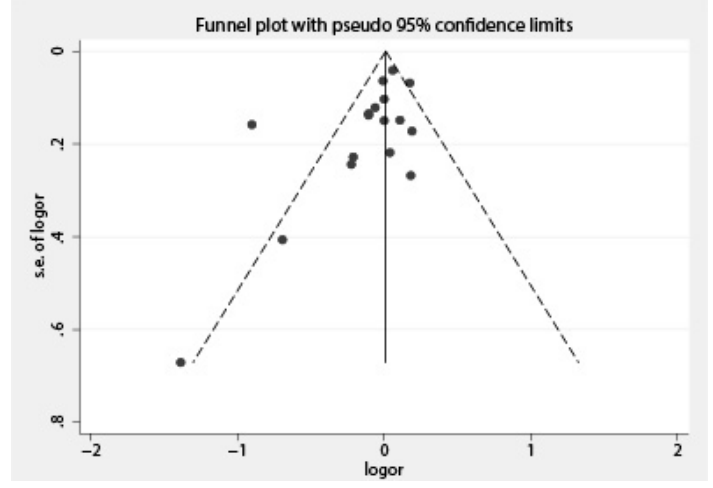
Figure 3. Funnel plot of the meta-analysis for the association between total dairy intake and risk of endometrial cancer.